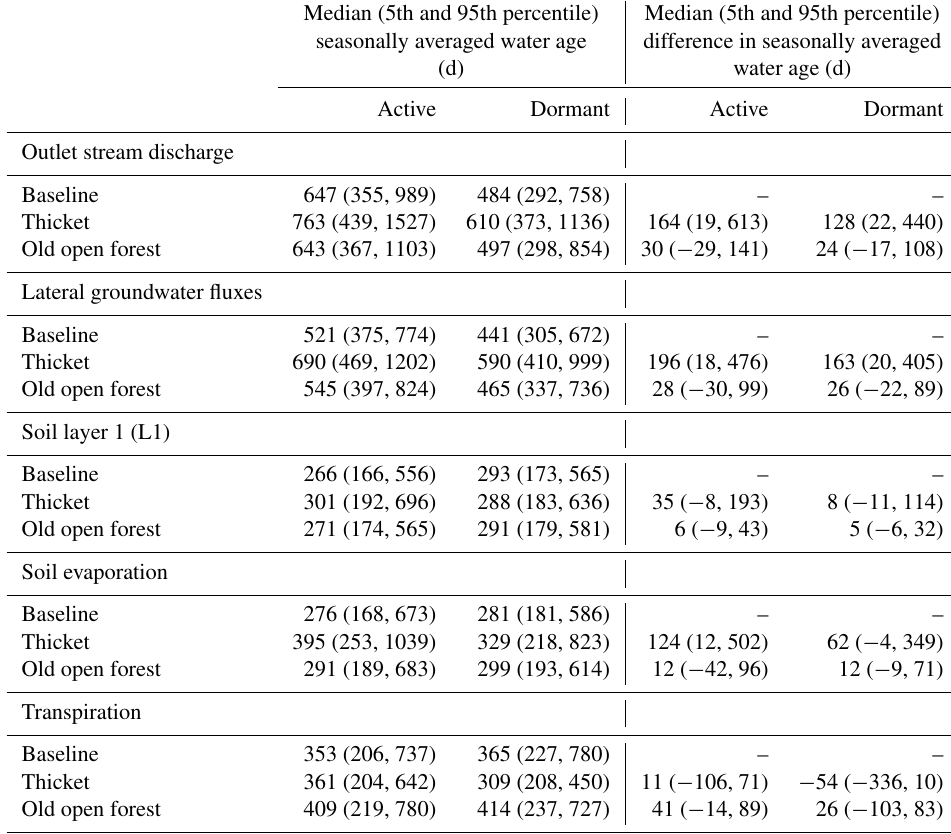
Table 4. Seasonally averaged water flux ages and differences in seasonally averaged ages. Averages and differences were calculated for each behavioural run individually and summarised by the median and 5th and 95th percentile (in parentheses) values across all behavioural runs. Differences are reported as regeneration scenario minus baseline and help indicate whether the simulated direction of change in the average age of each flux was consistent amongst behavioural models. Active and dormant seasons cover April to September and October to March,